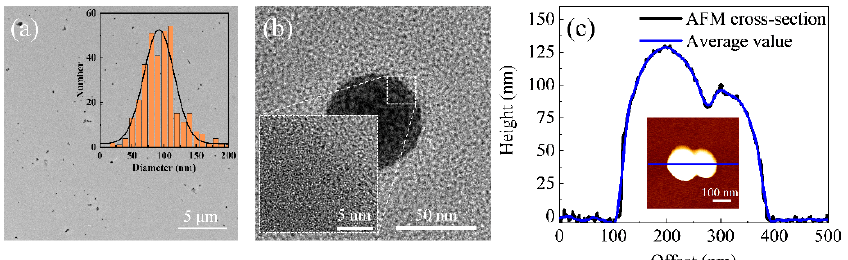
Figure 3. ( a ) TEM image of silicon nanospheres with an average diameter of 92 nm. ( b ) High-resolution TEM image of a silicon nanosphere. ( c ) Typical AFM topographic image of the silicon dimer with diameters of about 128.5 nm and 95.9 nm and corresponding cross-section analysis along the longitudinal axis of silicon dimer.